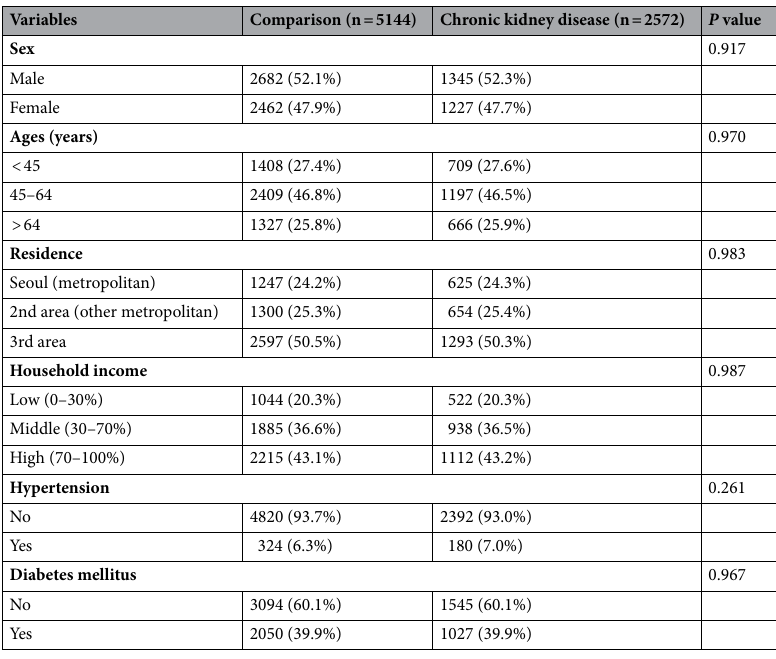
Table 1. Characteristics of the study participants. SSNHL, Sudden sensorineural hearing loss; Seoul, a largest metropolitan; 2nd area, other metropolitan cities; 3rd area, other